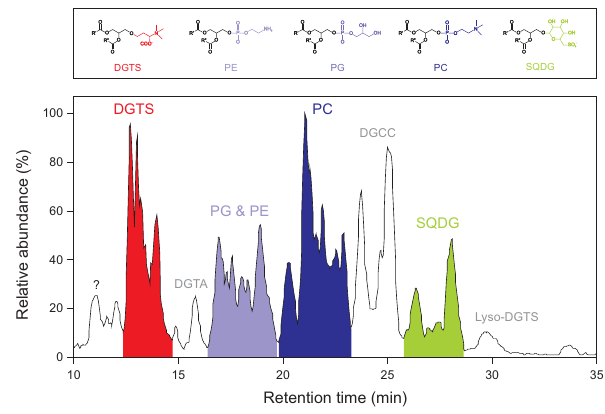
Fig. 4. Partial base peak chromatogram (positive ion – Gaussian smoothed) showing the IPL classes identified in Marsdiep water during the phytoplankton spring bloom in late April. Unidenti- fied peaks are indicated with a question mark. Example structures are given for each of the quantified IPL classes: diacylglyceryl- trimethylhomoserine (DGTS), phosphatidylglycerol (PG), phos- phatidylethanolamine (PE), phosphatidylcholine (PC) and sulfo- quinovosyldiacylglycerol (SQDG). Each peak comprises a wide range of IPLs with the same head group, but different fatty acids at the sn -1 and sn -2 positions (R 0 and R 00 in the example structures). Due to differences in response factors between the IPL classes, their relative abundances in the base peak chromatogram are not neces- sarily indicative of their respective absolute